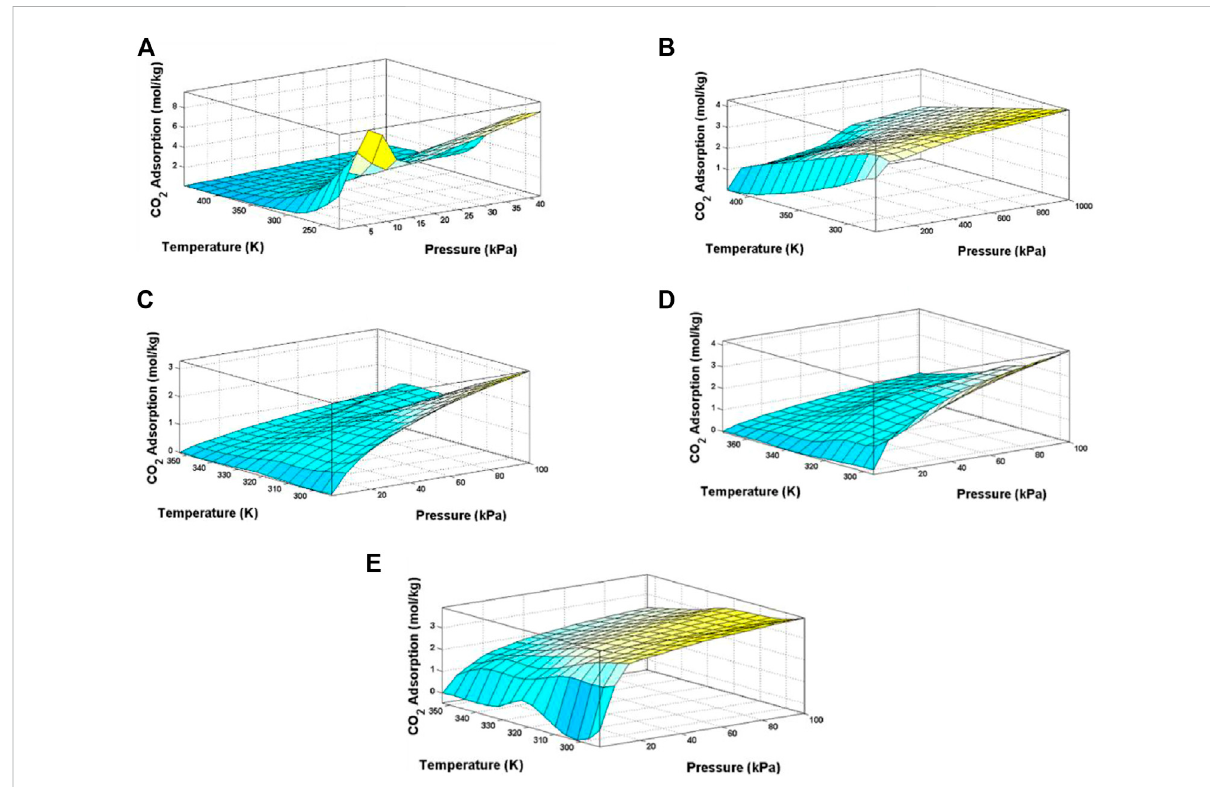
FIGURE 9 EffectofTemperatureandpressureonCO 2 adsorption(axialZ)onvarioustypesofzeolite (A) 13X, (B) 5A (C) SAPO-34 (D) SSZ-13and (E) T-Type (Raji et al.,